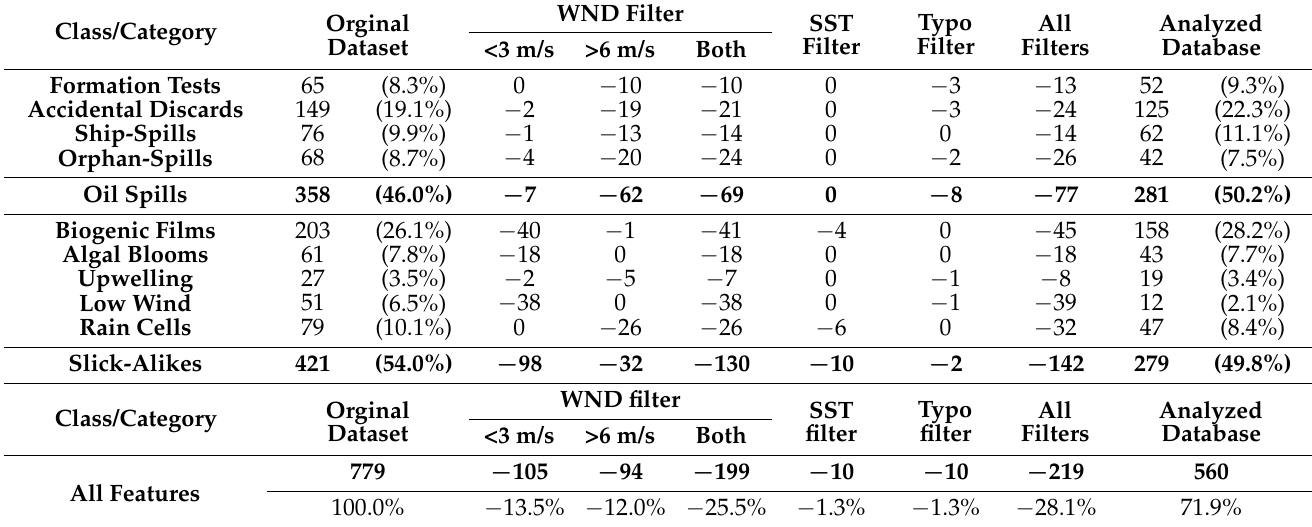
Table 2. Summary of the data-filtering scheme showing the number of eliminated records. Wind speed (WND) filter: <3 m/s and >6 m/s. Sea surface temperature (SST) filter: <11 ◦ C. Transcription errors (typo) filter. The statistics of all removed samples, of the original dataset instances [46], and of the analyzed database are also given. See also Section